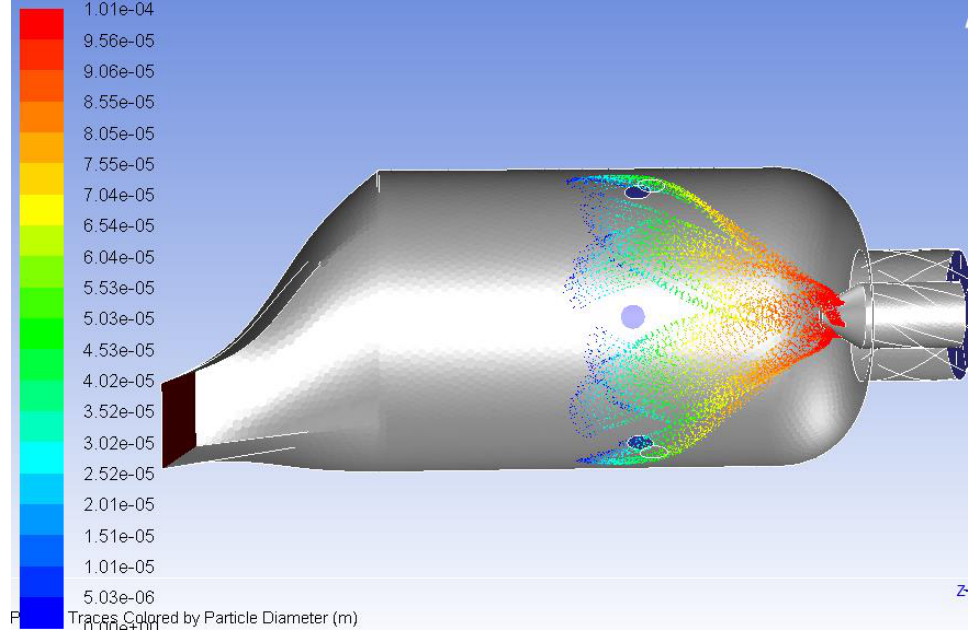
Figure 4. Profile of droplet diameter starting from the injection until full evaporation.